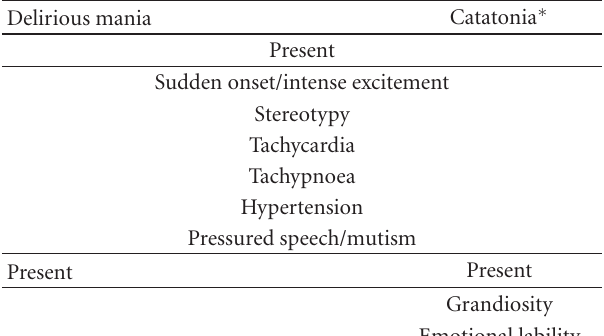
Table 2: Catatonia subgroups: symptoms of delirious mania and catatonia [3,